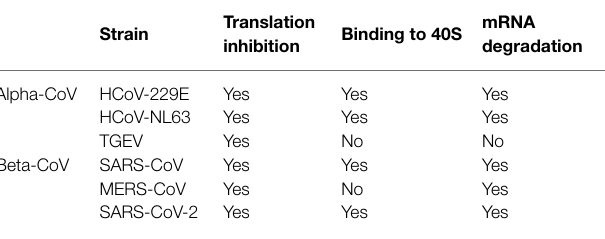
TABLE 1 | Summary of coronavirus Nsp1 functions. Translation Strain